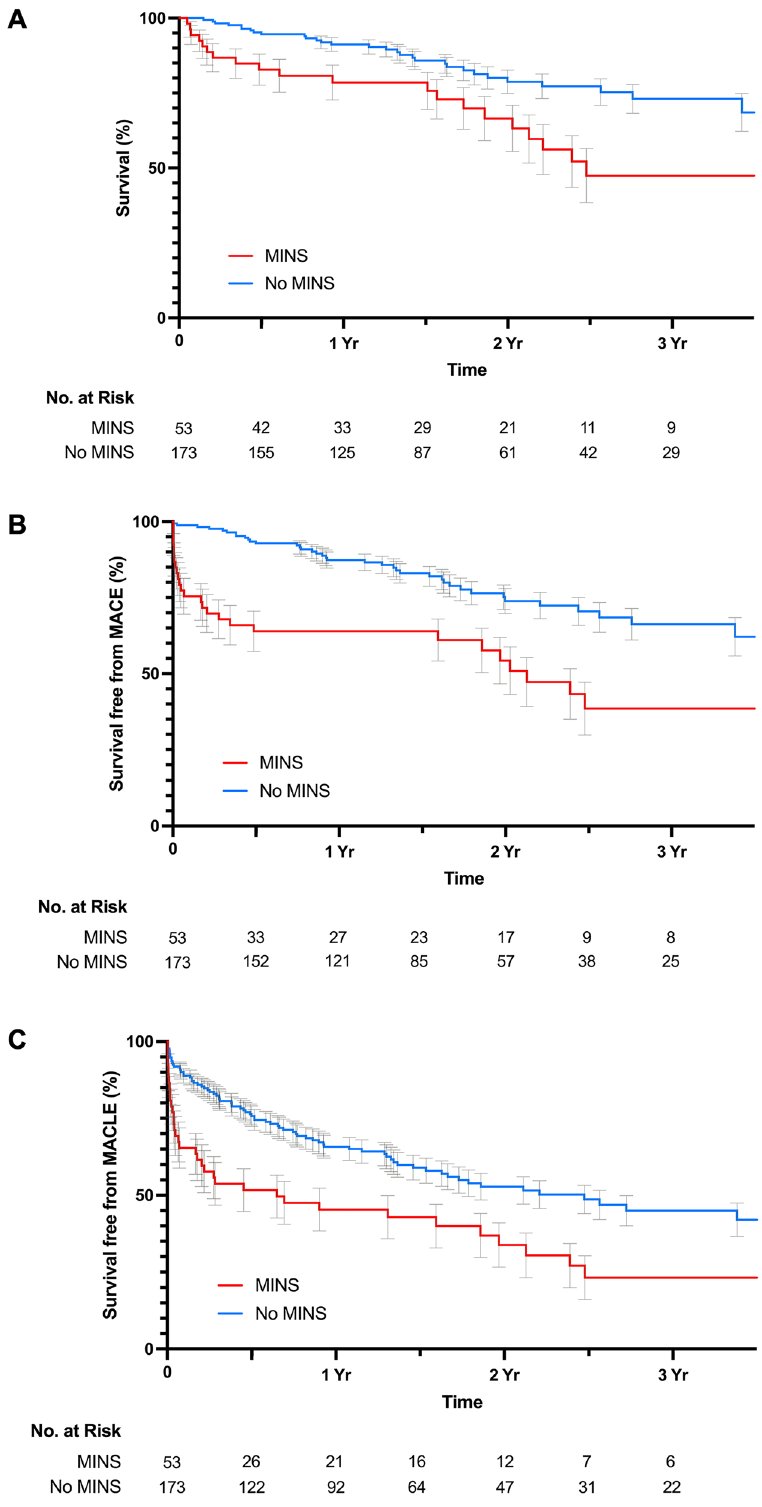
Figure 1. ( A ) Freedom from mortality after lower extremity revascularization. Log rank p-value = 0.003. Hazard Ratio 2.31 (95% CI 1.31–4.07). ( B ) Freedom from the composite of death, myocardial infarction, or stroke after lower extremity revascularization. Log rank p-value <0.0001. Hazard Ratio 2.74 (95% CI 1.66– 4.52) ( C ) Freedom from the composite of death, myocardial infarction, stroke, lower extremity amputation or reintervention after lower extremity revascularization. Log rank p-value <0.001. Hazard ratio 1.99 (CI 1.34–